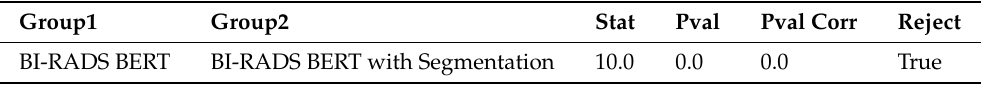
Table A23. McNemar test results for field extraction of previous cancer.